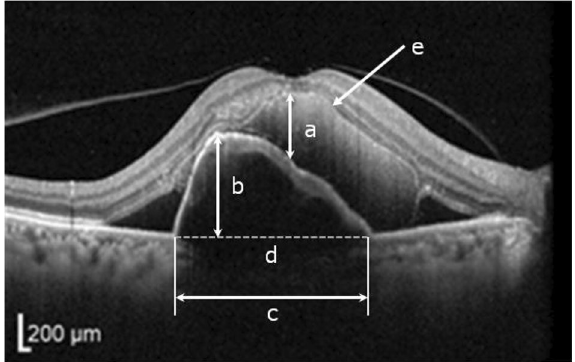
Figure 5. Measurement of preoperative OCT parameters. Preoperative OCT with SMH. (a) SMH height. (b) PED height. (c) PED width. (d) Presumed RPE line. (e) Ellipsoid zone